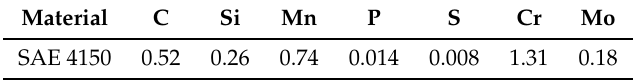
Table 1. Chemical composition of the SAE 4150 in wt.%.